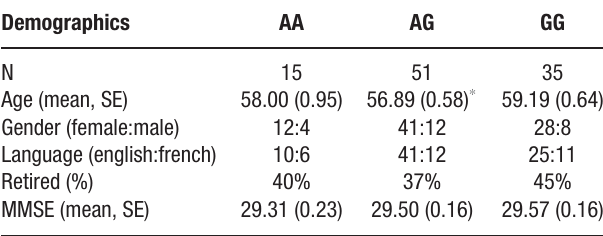
Table 2 . Demographic factors across genotype